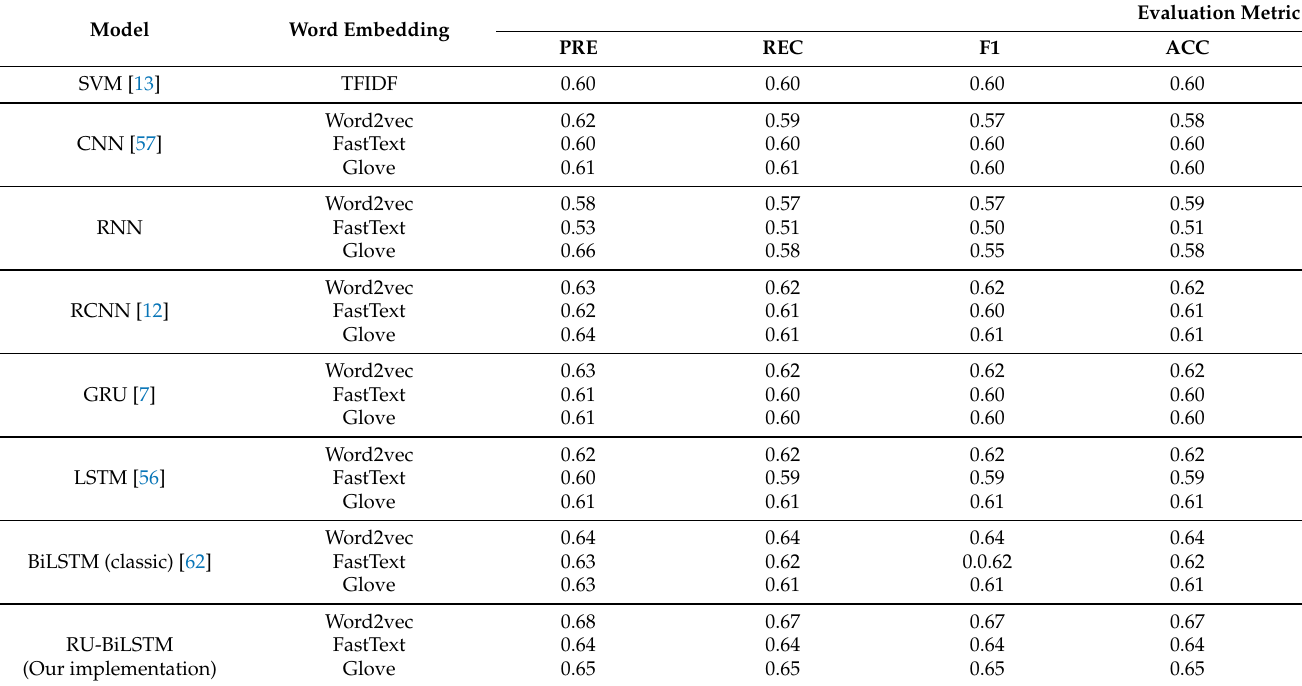
Table 6. Comparison of different evaluation measures of baseline models with our proposed model for Roman Urdu Sentiment